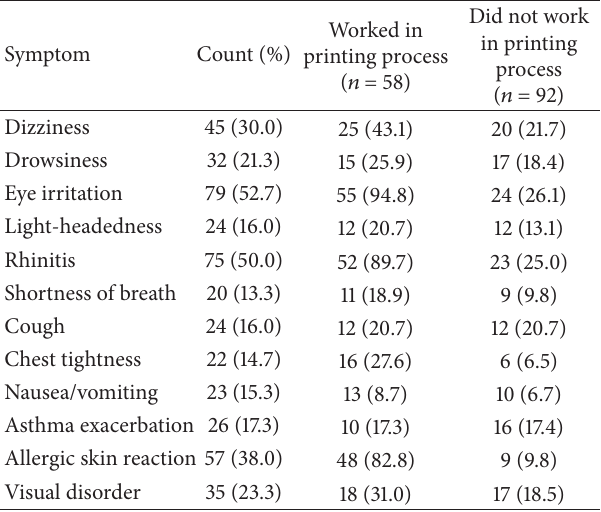
Table 3: Prevalence (percent) of acute symptoms during the preceding 6 months ( 𝑛 = 150).